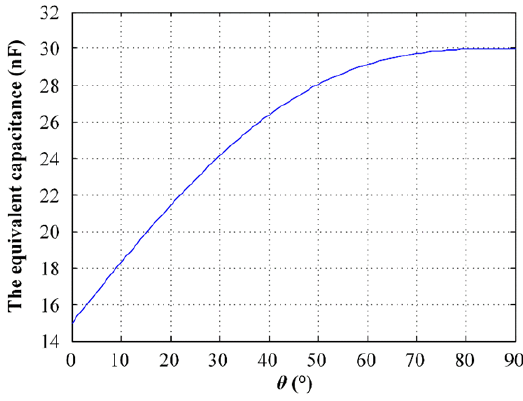
Figure 8. The equivalent capacitance versus θ.